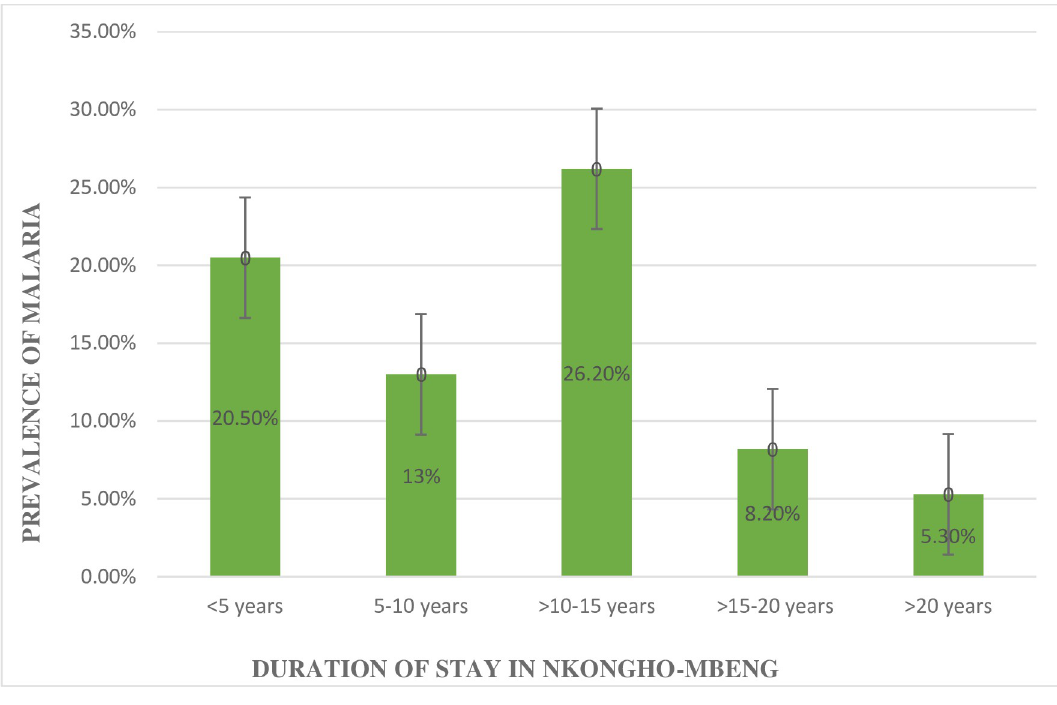
Fig 3. Relationship between the prevalence of malaria and duration of stay in Nkongho-mbeng.